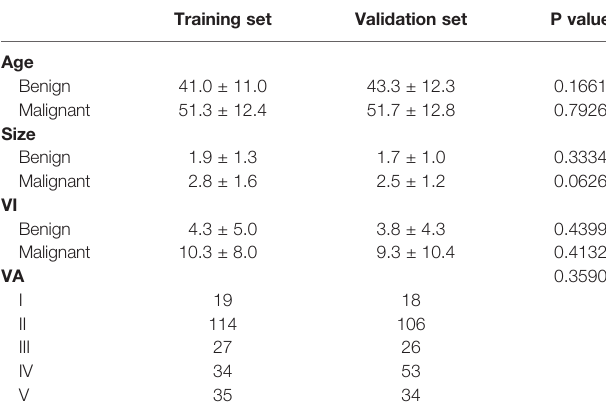
TABLE 4 | The clinical and SMI characteristics of training set and validation set. Training set